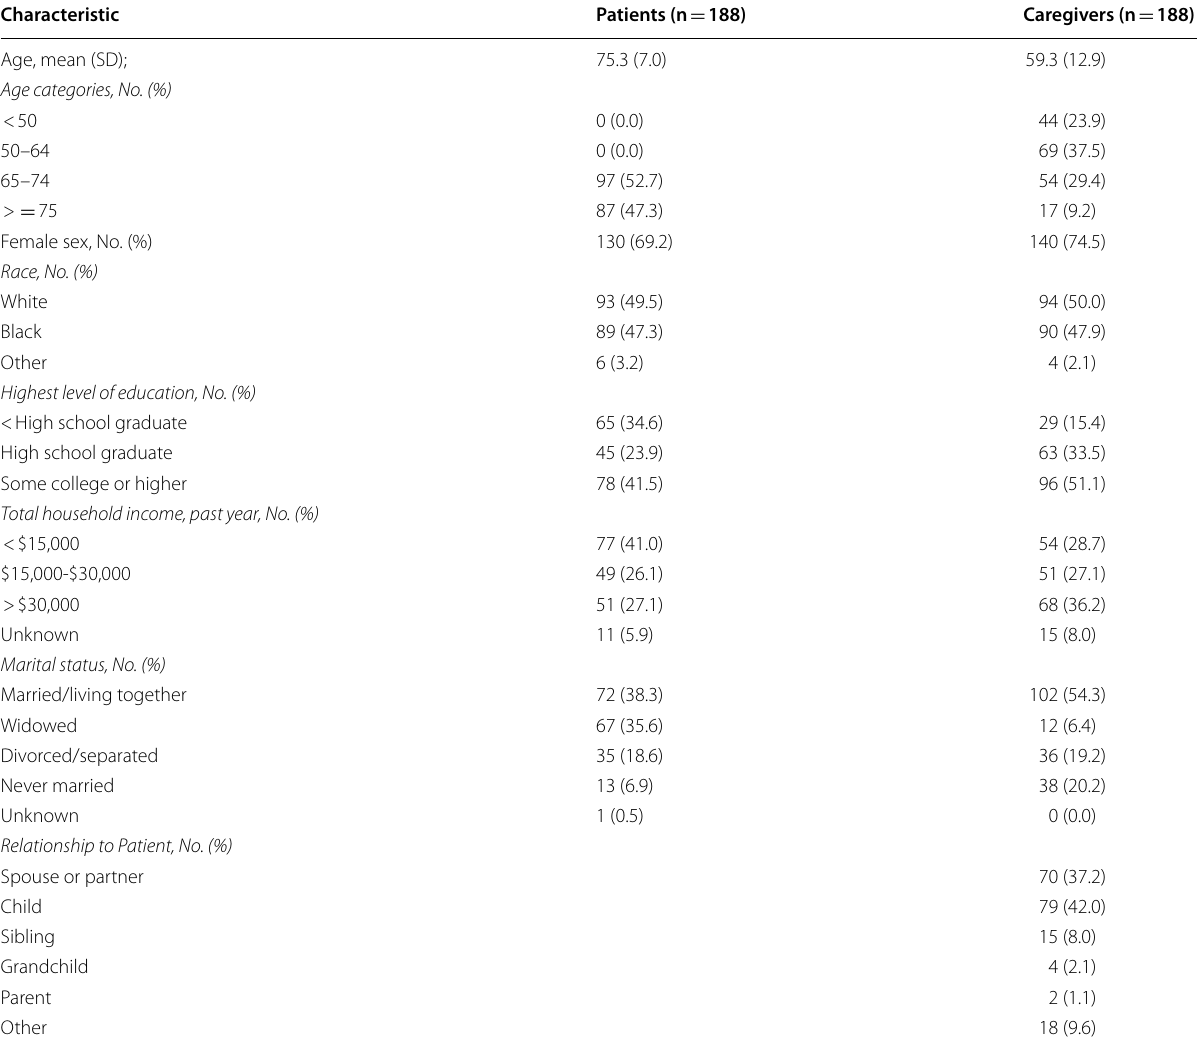
Table 1 Characteristics of patient and caregiver dyads Characteristic Patients (n